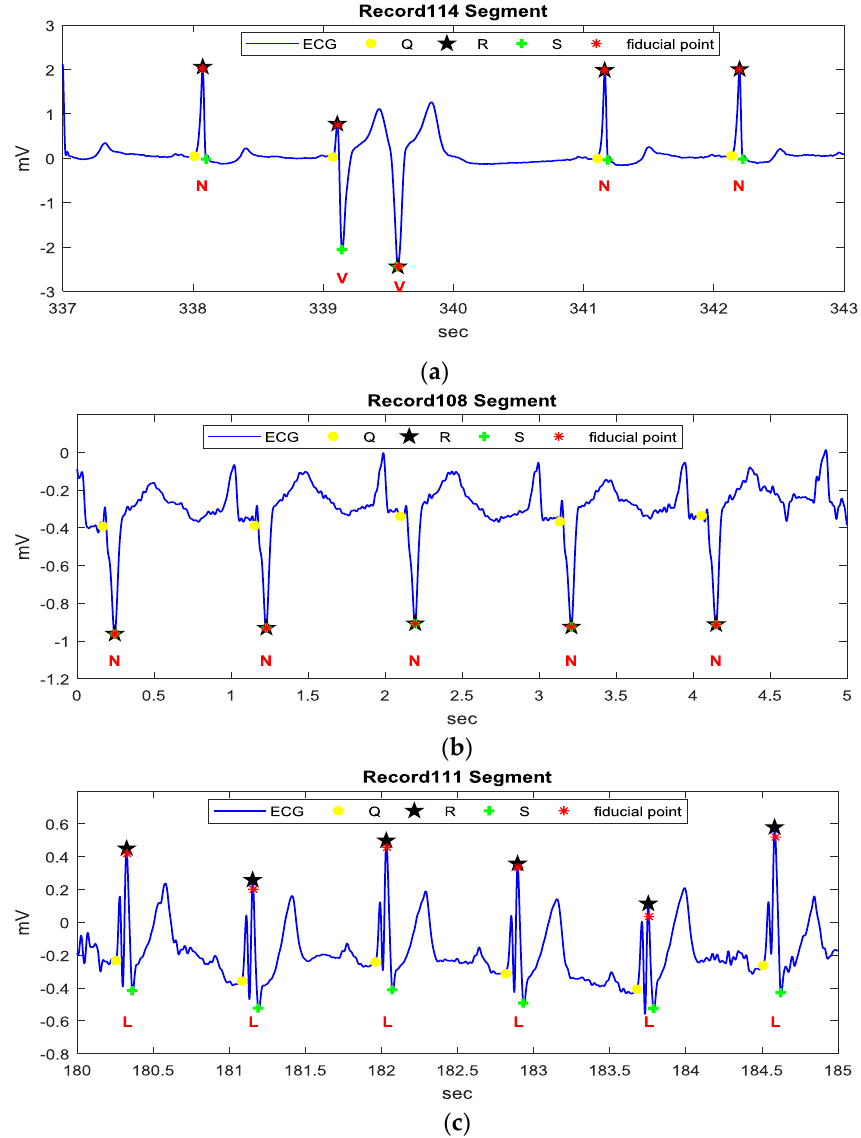
Figure 12. The detected QRS fiducial points and R points using the proposed method: ( a ) recognized feature points for the Record 114 segment; ( b ) recognized feature points for the Record 108 segment; ( c ) recognized feature points for the Record 111 segment.